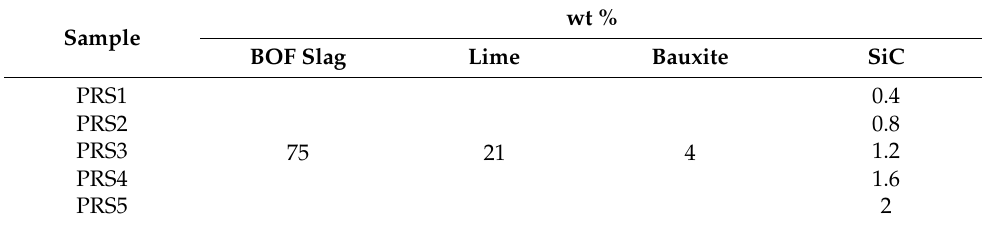
Table 4. Mix ratio of SiC foaming porous reconstructed steel slag.